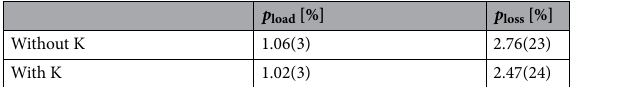
Table 1. Comparison of load and loss probabilities in a few atom sodium MOT with and without the presence of a potassium cloud. The uncertainties were obtained through bootstrap resampling.